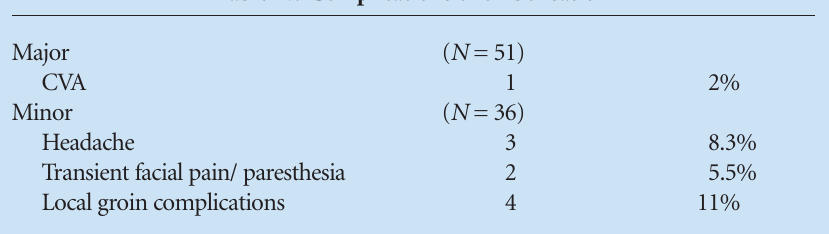
Table IV. Complications of